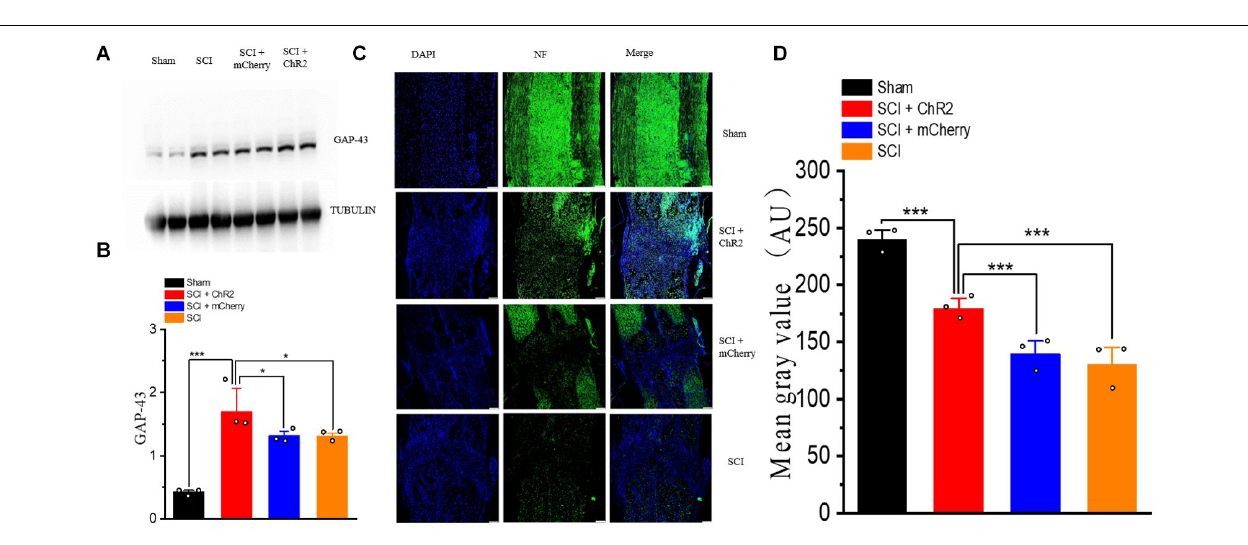
FIGURE 7 | Accurate stimulation of M1 glutamatergic neurons promotes the regeneration of nerve fibers after SCI in rats. (A) Display of WB bands of nerve growth-related molecule GAP-43. (B) Statistical analysis histogram of GAP-43 gray value. (C) Immunofluorescence staining of NF (neurofilament) in spinal cord tissue of rats in each group at the 6th week, blue staining for DAPI, and green staining for NF expression (200 µ m/bar). (D) Histogram of Mean Gray Value. [Protein content = target protein gray value/internal reference gray value; * P < 0.05, *** P < 0.001, n = 3 rat/group, using one-way ANOVA. Data are shown as means (bar graphs) and standard error of the mean (error bars), with individual data points indicated as